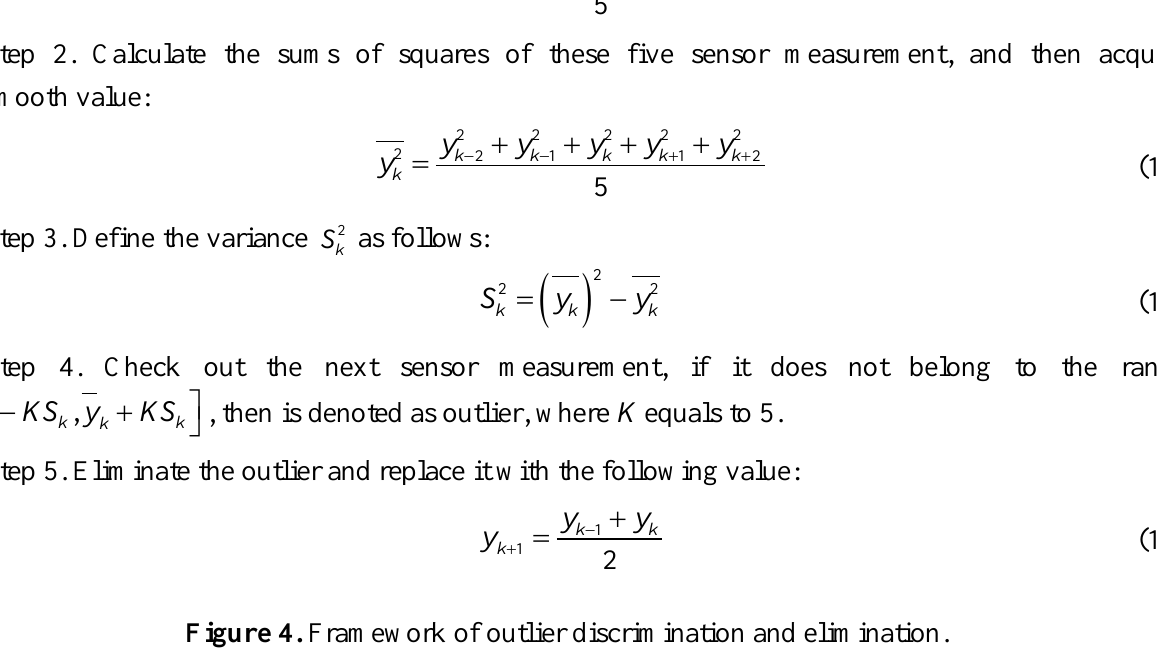
Figure 4. Framework of outlier discrimination and elimination.